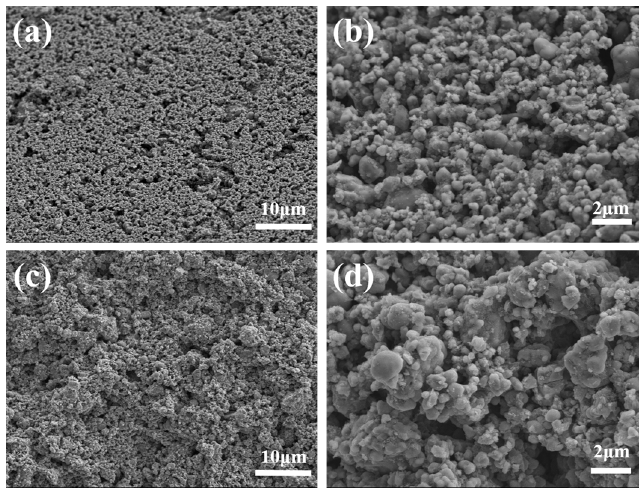
Figure 9. SEM images of the cross section of printed LFP electrodes: ( a , b ) room temperature printed LFP electrodes; ( c , d ) LTDW printed LFP electrodes.